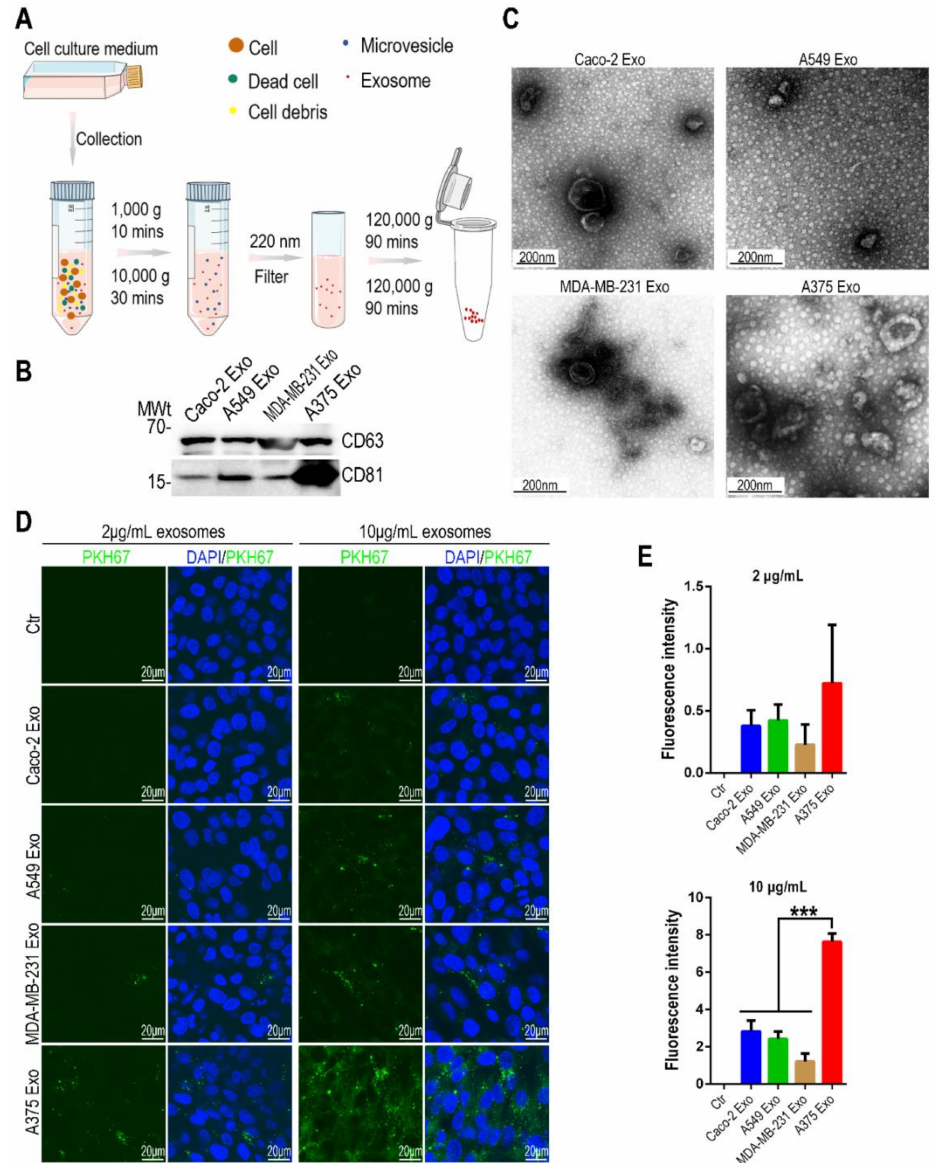
Figure 1. Exosomes derived from A375 cells were more easily absorbed by human brain microvascular endothelial cells. ( A ) Schematic diagram of exosomes purification from tumor cells by differential centrifugation. ( B ) Western blotting showing protein level of exosomal markers (CD63, CD81) in 4 types of tumor cell-derived exosomes ( n = 3). ( C ) Representative TEM images of 4 types of tumor cell-derived exosomes ( n = 2). ( D ) Representative confocal images of hCMEC/D3 cells 24 h after incubation with exosomes (2 µ g/mL and 10 µ g/mL) derived from 4 different types of tumor cells ( n = 4). Exosomes were labeled by PKH67 (green) fluorescent dye. ( E ) Quantification of PKH67 fluorescence intensity for each group based on ( D ) ( n = 4). Data are presented as mean ± SEM, and are analyzed using a one-way ANOVA with Bonferroni post-test (***: p <